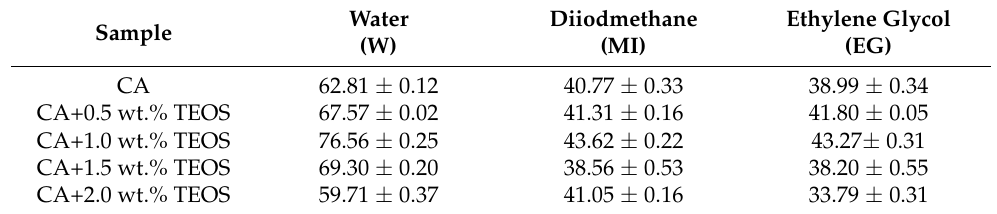
Table 3. Contact angle θ ( ◦ C), between the different test liquids and cellulose acetate/silica films.